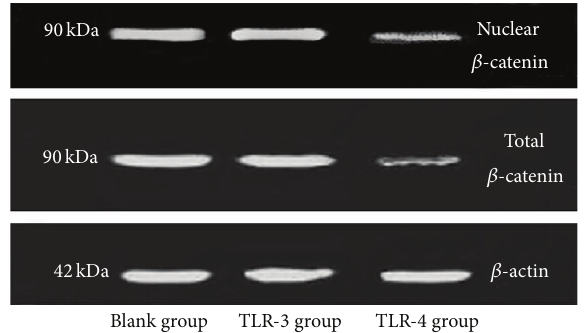
Figure 5: Expression of 𝛽 -catenin. Western blotting analysis was used to access the expression of total 𝛽 -catenin and nuclear 𝛽 -catenin in OBs stimulated by TLR-3 ligands (𝑛 = 12) and TLR-4 ligands (𝑛 = 12) . Untreated OBs were used as negative control (𝑛 = 12) . More expression of 𝛽 -catenin indicated better activation of Wnt signaling pathway. TLR-4 ligands inhibited Wnt signaling pathway, while TLR-3 ligands did not affect that mechanism.